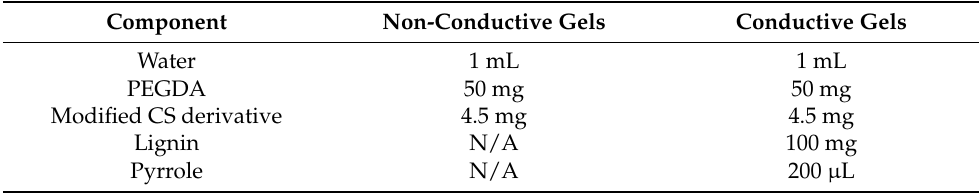
Table 1. Formulations used for the preparation of non-conductive and conductive